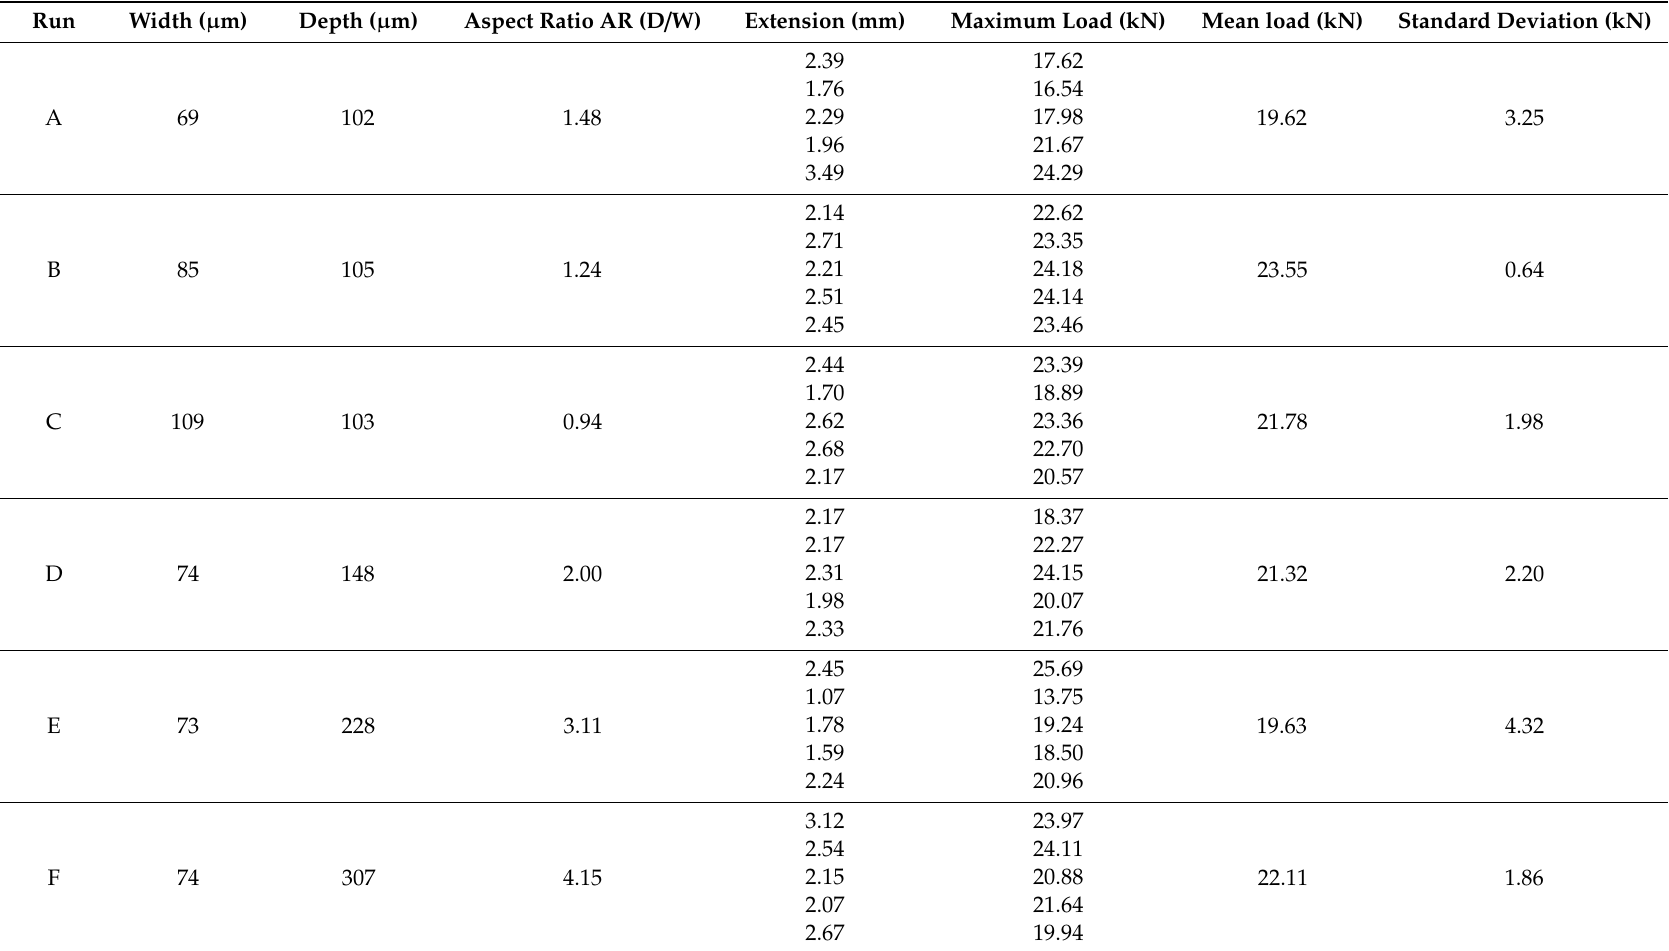
Table 6. Lap shear strength results for di ff erent AR